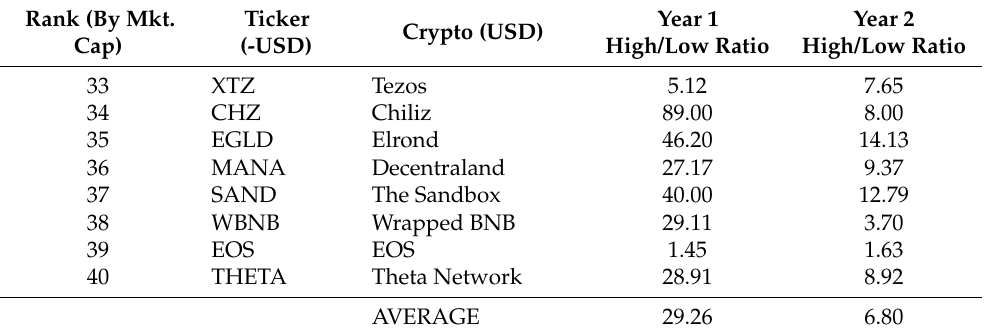
Table 4. Cont. Rank (By Mkt.